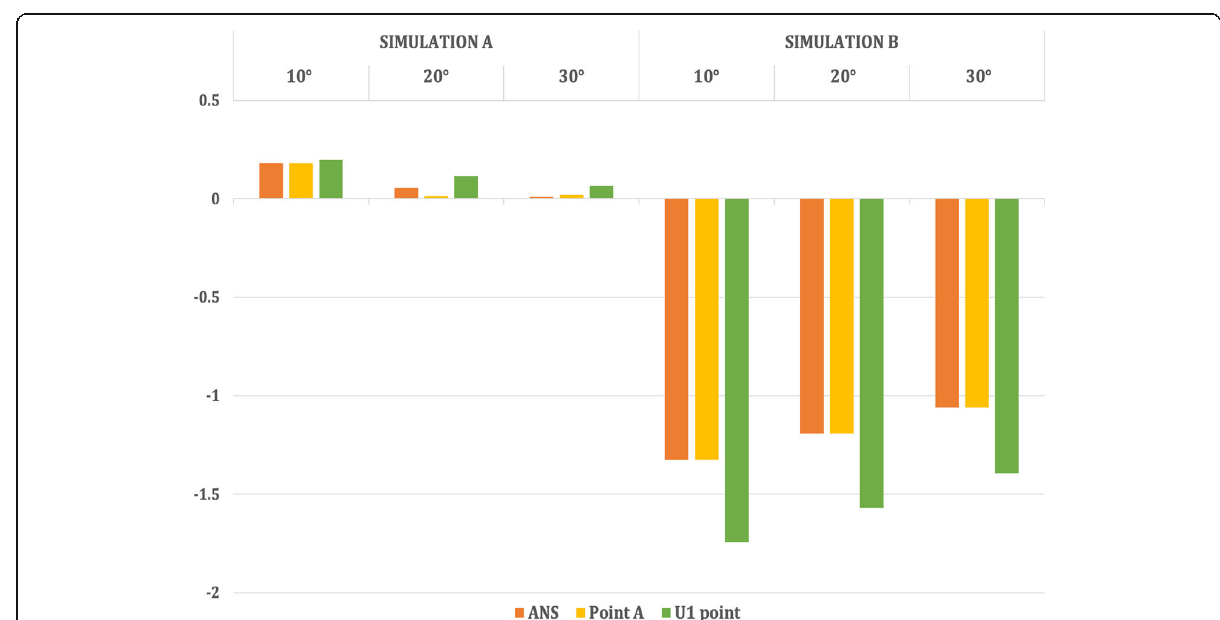
Fig. 7 Vertical displacement of the maxillary landmarks when 250 g of force was applied at the three angulations (10° to 30°)